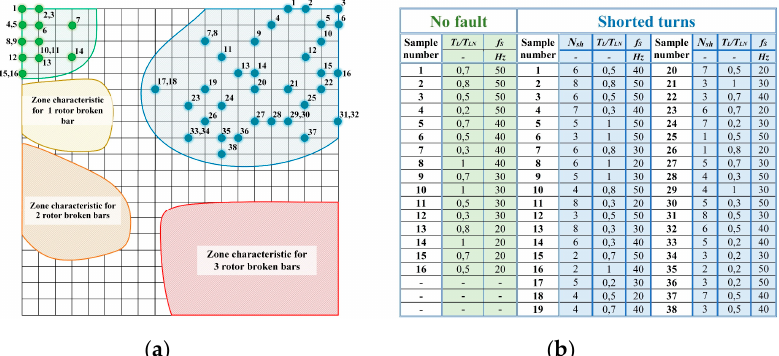
Figure 12. Classification of the stator windings faults: ( a ) Kohonen map (20 × 20): solid lines—IM damage categories involved in the classification, hatched areas—IM damage categories not involved in the classification; ( b ) specification of test data parameters; T L —load torque, T LN —rated motor torque, f s — frequency of the supply voltage, N sh —number of shorted turns in the stator winding.